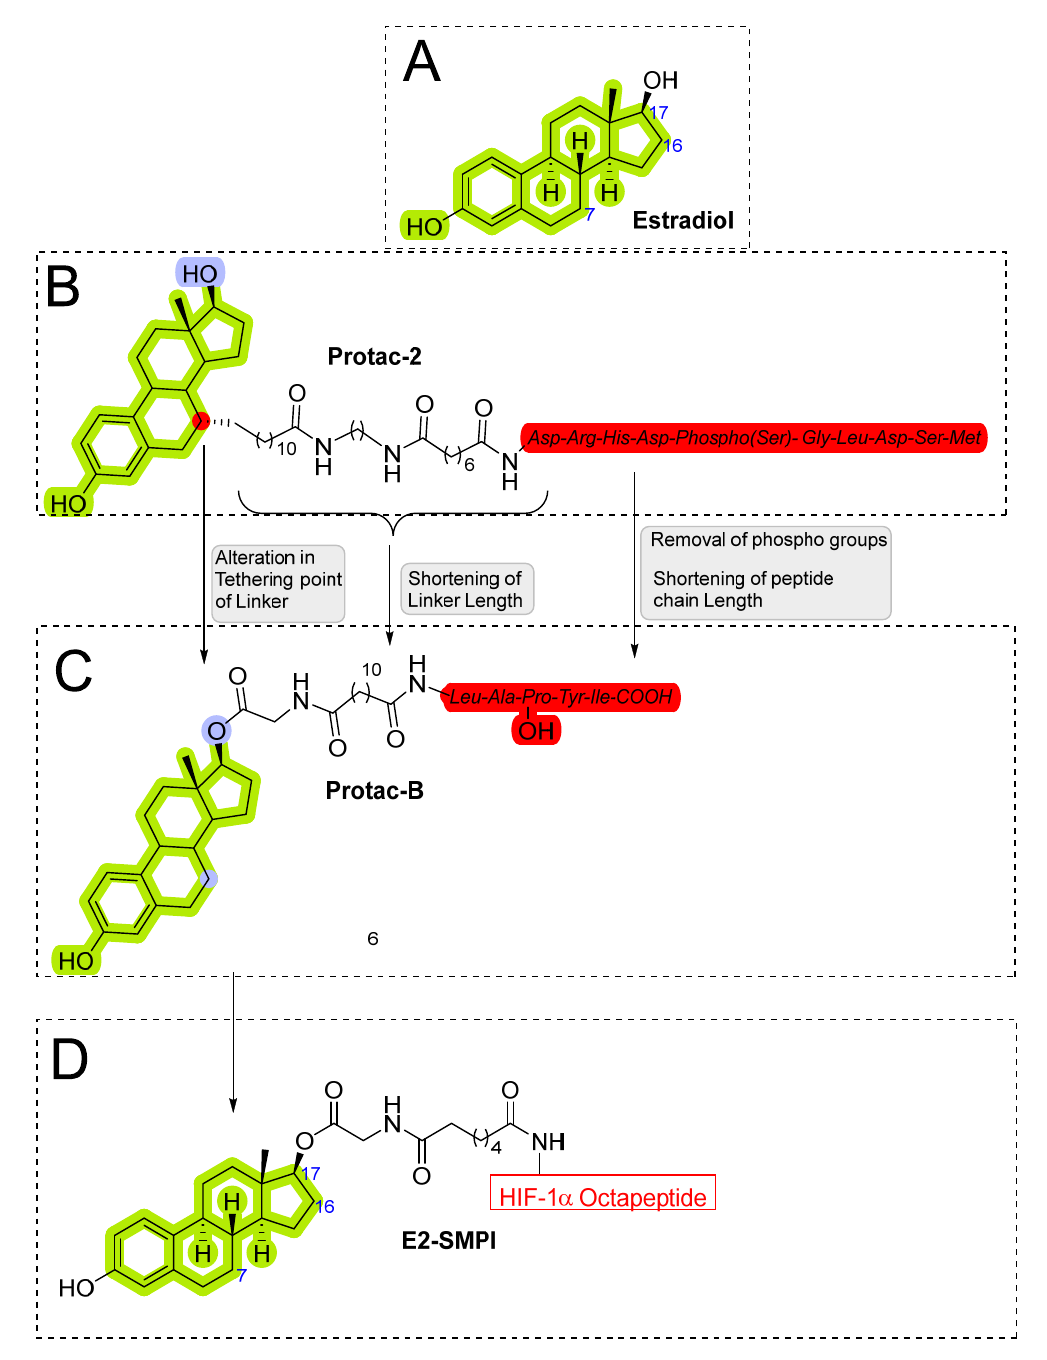
Figure 6. ( A ) Structure and numbering of Estradiol, a common ligand scaffold used for ER degra- dation. ( B ) Steroidal-based peptide PROTACs ( Protac-2 ). ( C ) Chemical alteration yielded Protac-B . ( D ) Chemical structure of E2-SMPI .